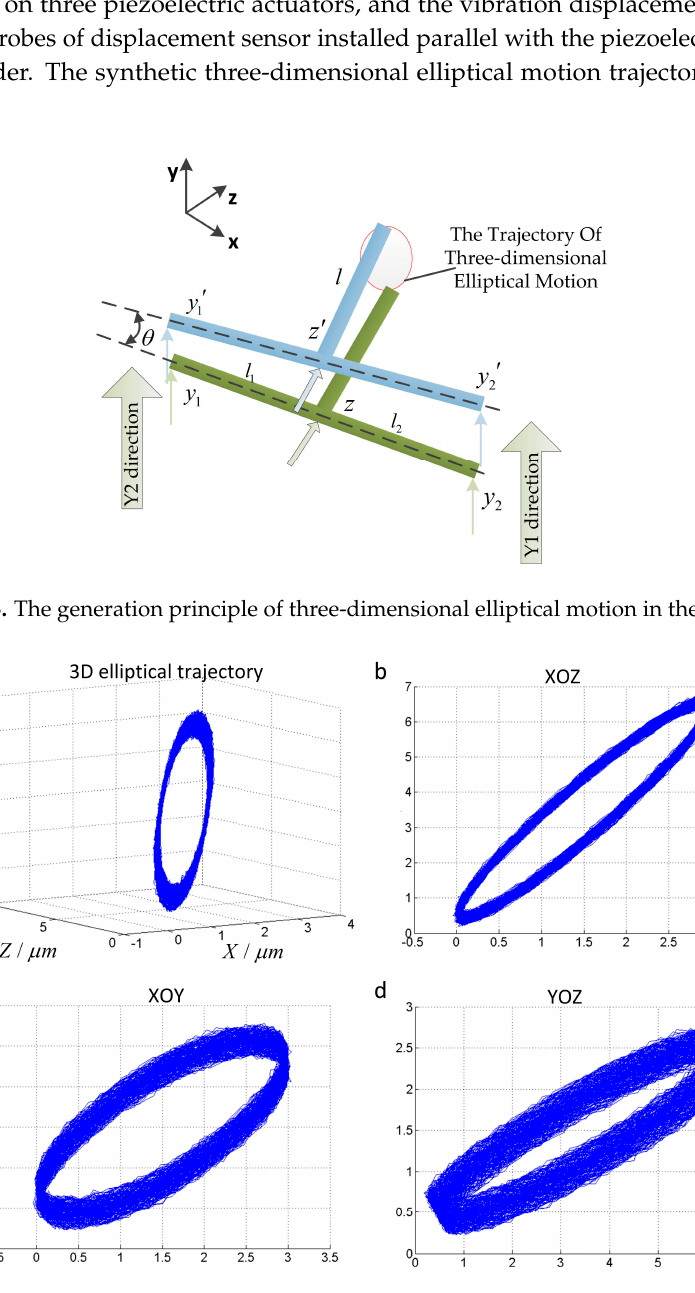
Figure 4. Tool trajectory of non-resonant three-dimensional elliptical vibration cutting (3D-EVC). A 1 = 7 μ m, A 2 = A 3 = 4 μ m, φ 1 = 0, φ 2 = π /2, φ 3 = π , ω 1 = ω 2 = ω 3 = 50 HZ. ( a ) The spatial elliptical trajectory; ( b ) The projection of the 3D elliptical trajectory in the XOZ plane; ( c ) The projection of 3D elliptical trajectory in the XOY plane; ( d ) The projection of the 3D elliptical trajectory in the YOZ plane.